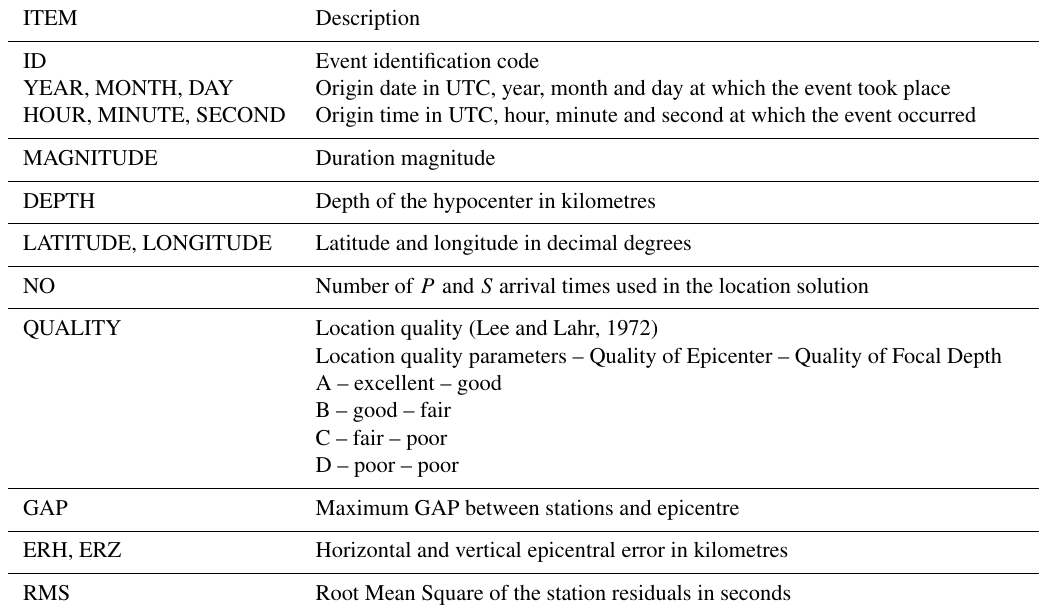
Table 1. Description of the GeoDatabase items.